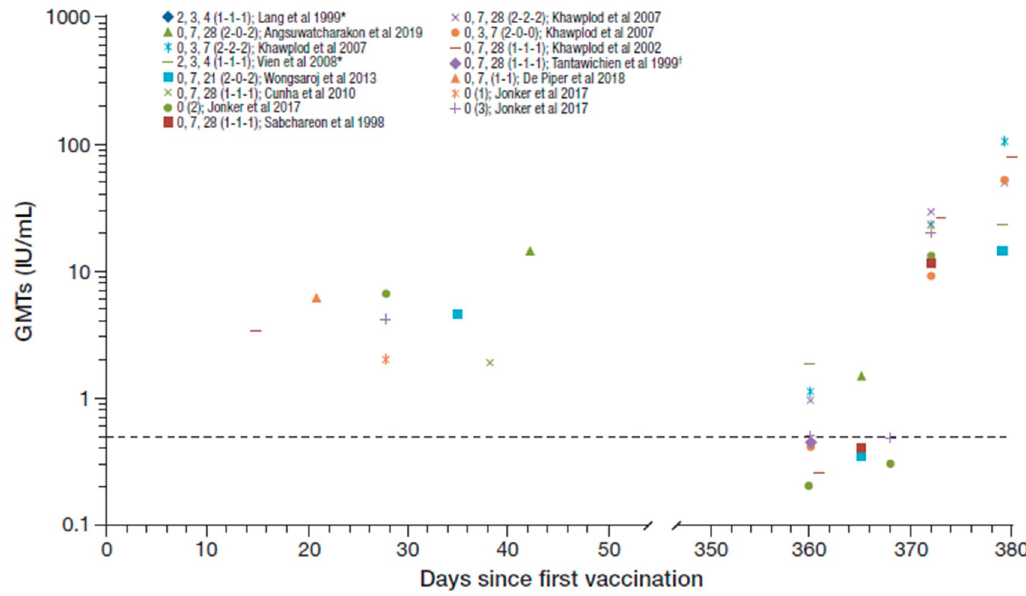
Figure 2. Summary of PrEP immunogenicity data from studies with purified Vero cell rabies vaccine (PVRV) intradermal (ID) identified irrespective of regimen [regimen summarized as day of vaccination (number of sites per vaccination day) in legend key]. Data shown to the right are post-booster geometric mean titers (GMTs). *The Lang et al. and Vien et al. studies are the same cohort, and regimen shows age at vaccination (i.e., at 2, 3, and 4 month of age). † GMT reported as 0.4 and 0.43 in two groups (average 0.42 used here). Dotted line marks the 0.5 IU/ml rabies virus neutralizing antibodies (RVNA) titer.